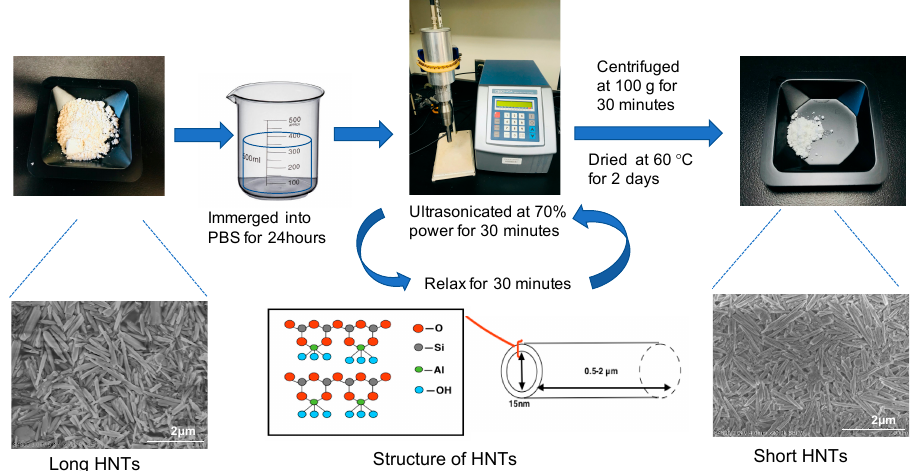
Figure 1. The process of reducing the length of halloysite nanotubes (HNTs). Between each step, the composites were washed and filtered using methanol, sodium chloride, a sodium bicarbonate solution, and distilled water (DI).